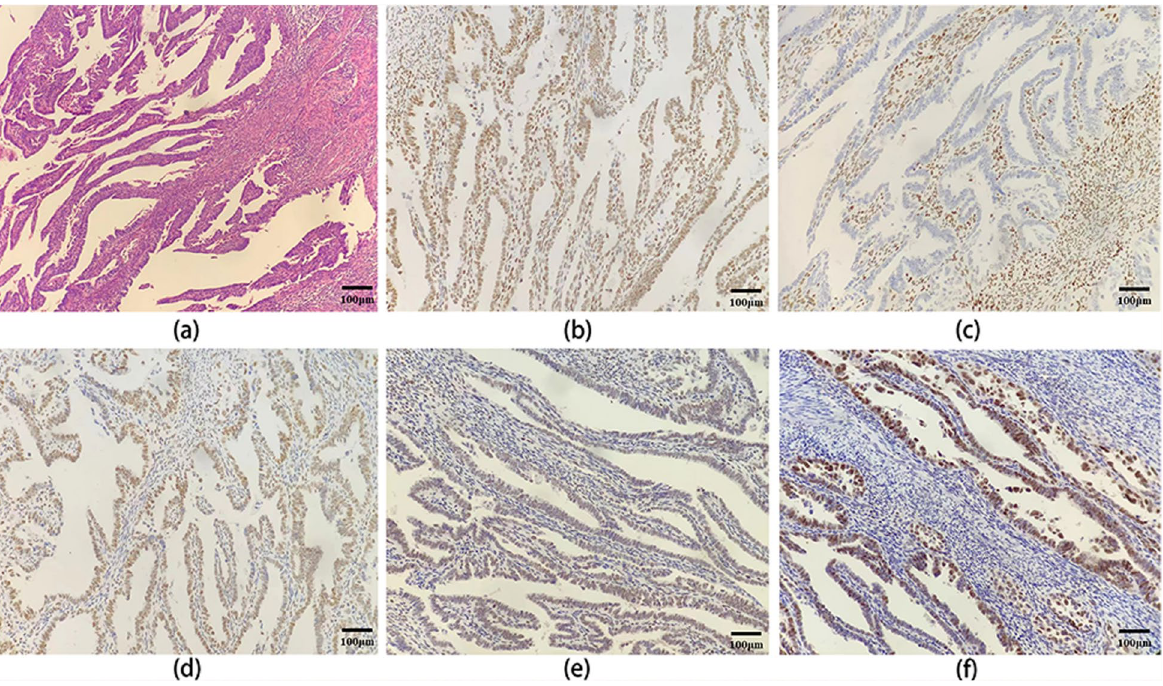
Fig. 1 Immunohistochemical stains for MMR proteins (A: MSH2, B: MSH6, C: MLH1, D: PMS2) and p53 protein (F). Magnification: 100